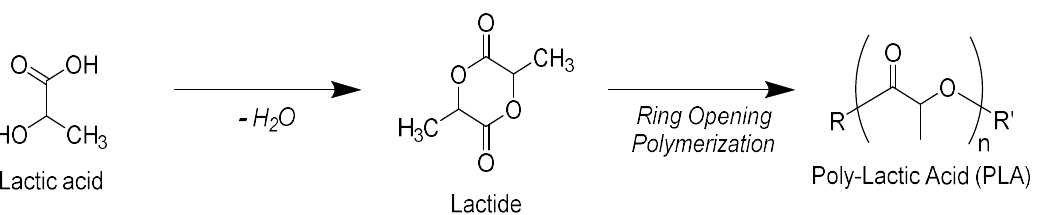
Figure 1. Ring opening polymerization route for the production of polylactic